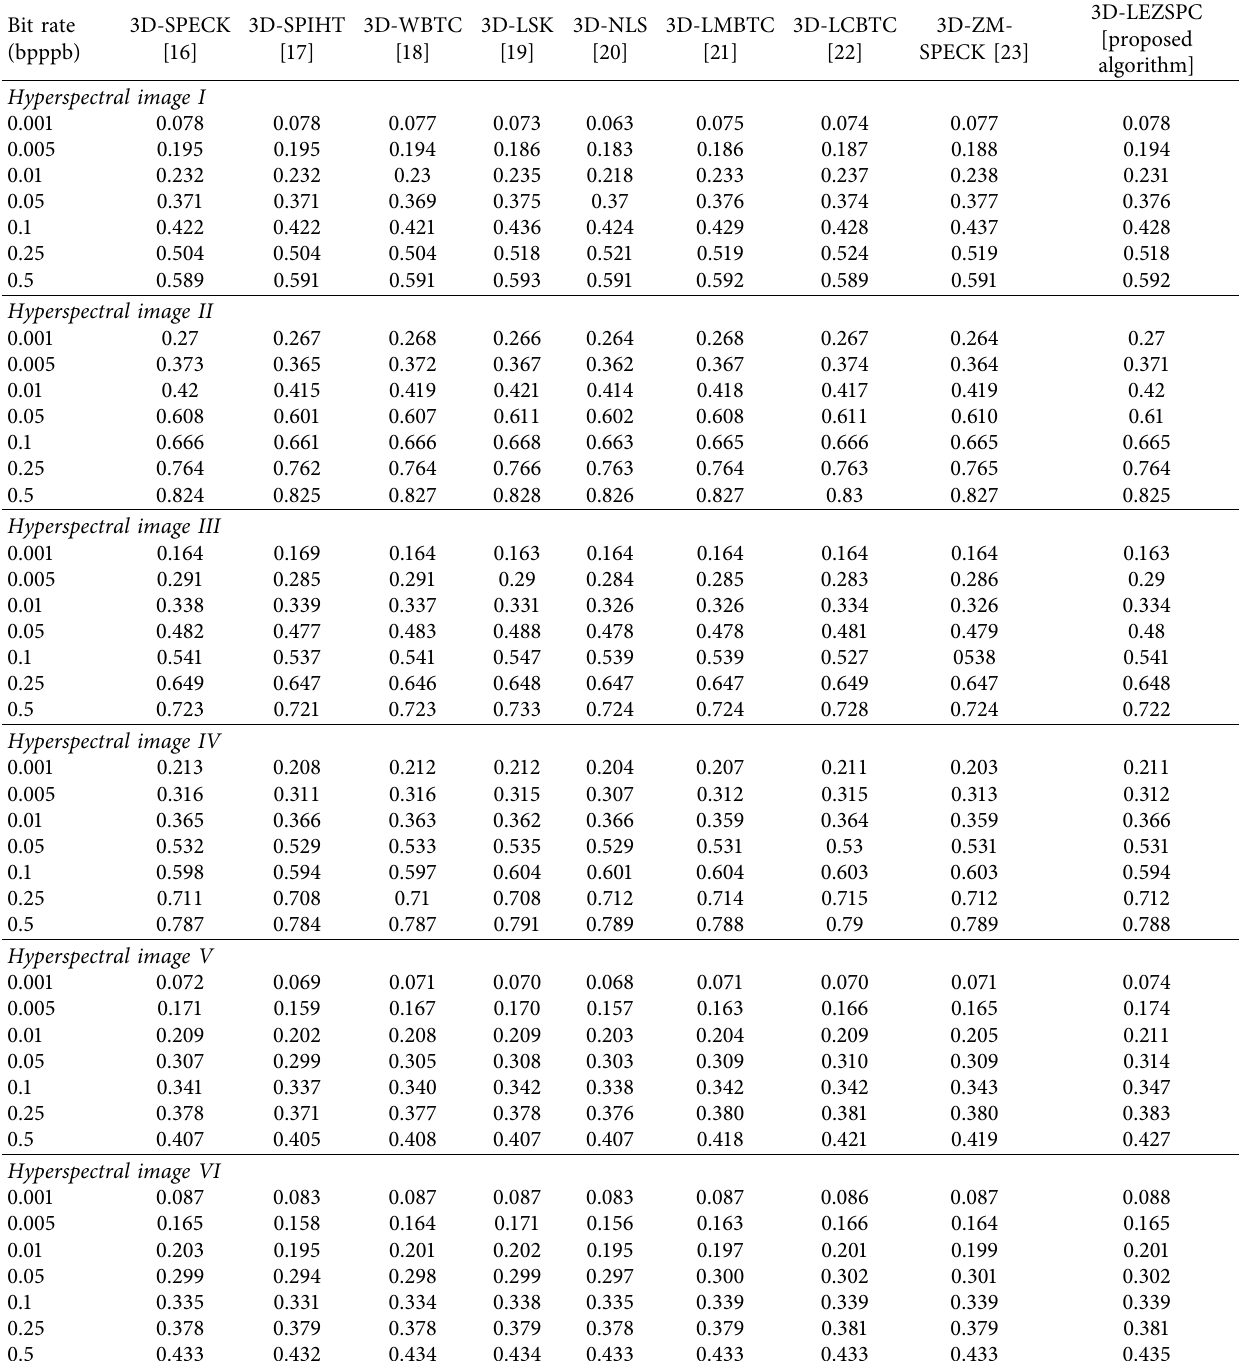
Table 4: Comparative analysis of the structural similarity (SSIM) index between the 3D-LEZSPC with the other wavelet transform based set partitioned